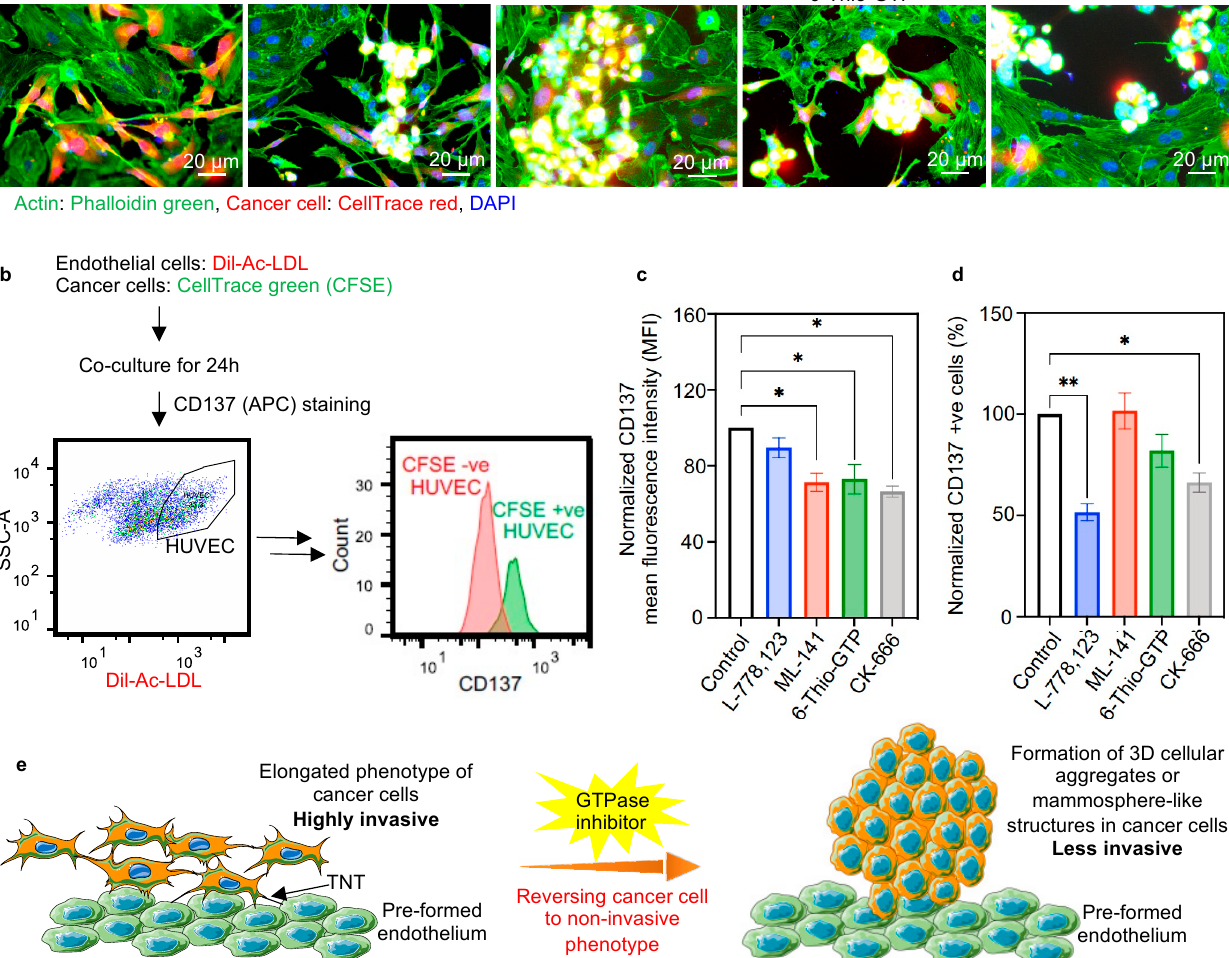
Figure 4. Reversal of phenotypic transition in the presence of inhibitors. ( a ) Representative images of co-culture of cancer cells and endothelial cells in the 3D tumor matrix, showing the reversal of the phenotypic transition of cancer cells from a highly invasive elongated phenotype to 3D cellular aggregates or mammosphere-like structures with the effect of inhibitors. Cancer cells (MDA-MB-231) were stained with CellTrace red and co-cultured with unstained endothelial cells. Co-cultures were set up in the absence and presence of inhibitors (10 µM each, 40 µM for CK-666). After 24 h of co-culture, the cells were stained with phalloidin green; nuclei were counterstained with DAPI and imaged under a fluorescence microscope. The mammosphere formation (yellow signal) was observed in the cancer cells in the presence of inhibitors. ( b ) Experimental design for checking the relative expression of tumor endothelial markers in HUVECs after being involved in nanoscale communication with cancer cells. HUVECs were stained with Dil-Ac-LDL and co-cultured with CFSE stained cancer cells (MDA-MB-231). The histogram showing CFSE +ve HUVECs, i.e., the cells that received cytoplasmic components from cancer cells, exhibited higher CD137 expression than CFSE-ve HUVECs. ( c ) Representative bar plot showing CD137 mean fluorescence intensity (MFI) of CFSE +ve HUVECs in the presence of GTPase inhibitors. A significant reduction of CD137 MFI was observed that signifies the reduced transfer of information from cancer cells to endothelial cells. ( d ) Bar plot showing the comparative population of CFSE +ve endothelial cell (Dil-Ac-LDL +ve) with high CD137 expression. A significant reduction in the number of cells expressing high CD137 was observed upon inhibitor treatment. This signifies the reduced transfer of information from cancer cells to endothelial cells. ( e ) Schematic representation of the effect of inhibitors on the phenotype transition of cancer cells. Metastatic cancer cells adopt an elongated phenotype in the presence of the endothelial layer. The elongated phenotype of cancer cells is able to participate in active communication with endothelial cells, and can easily invade the endothelial layer, resulting in enhanced metastasis. In the presence of GTPase inhibitors, cancer cells return to their original 3D cellular aggregates or mammosphere-like phenotypes, which are less invasive, and which correlate with cancer cells with a reduced chance of invasiveness. * p < 0.05, ** p <